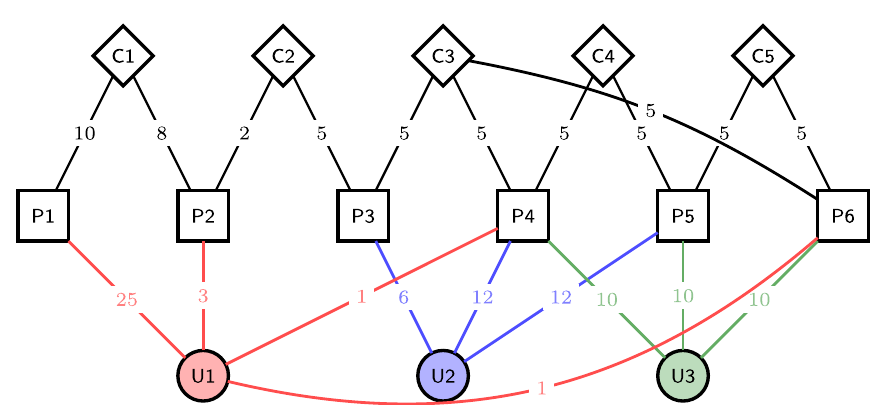
Fig. 1 Example of a tripartite